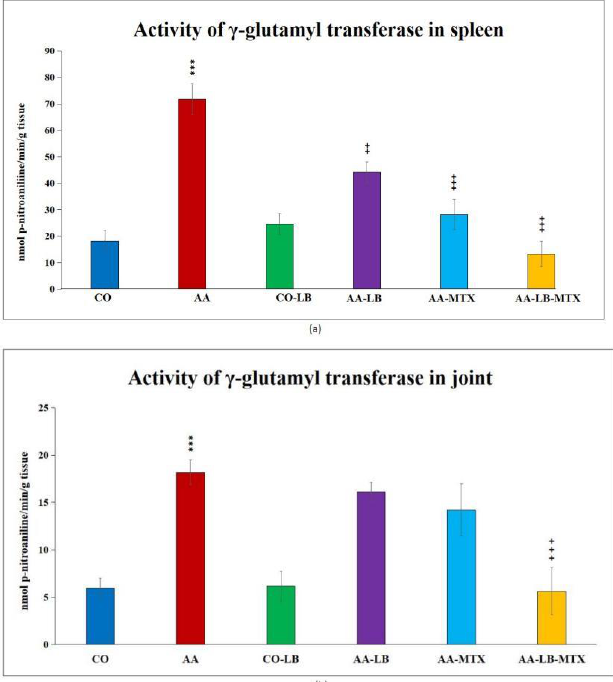
Figure 1. Change of hind paw volume (cHPV) ( a ) and change of body weight (cBW) ( b ) were as- sessed on experimental days 14, 21, and 28 in rats. CO — healthy control group, AA — group of con- trols with adjuvant arthritis (AA), CO-LB — a control group of healthy animals administered with L. plantarum (LB), AA-LB — group of animals with AA administered with LB, AA-MTX — rats with AA treated with methotrexate (MTX), AA-LB-MTX — group of rats with AA receiving combinational therapy of MTX and LB. Values are expressed as mean ± S.E.M. Statistical significance was evaluated by applying ANOVA for independent variables: *** p < 0.001 vs. CO; +++ p < 0.001 vs. AA; # p < 0.05 and ## p < 0.01 vs. AA-MTX.